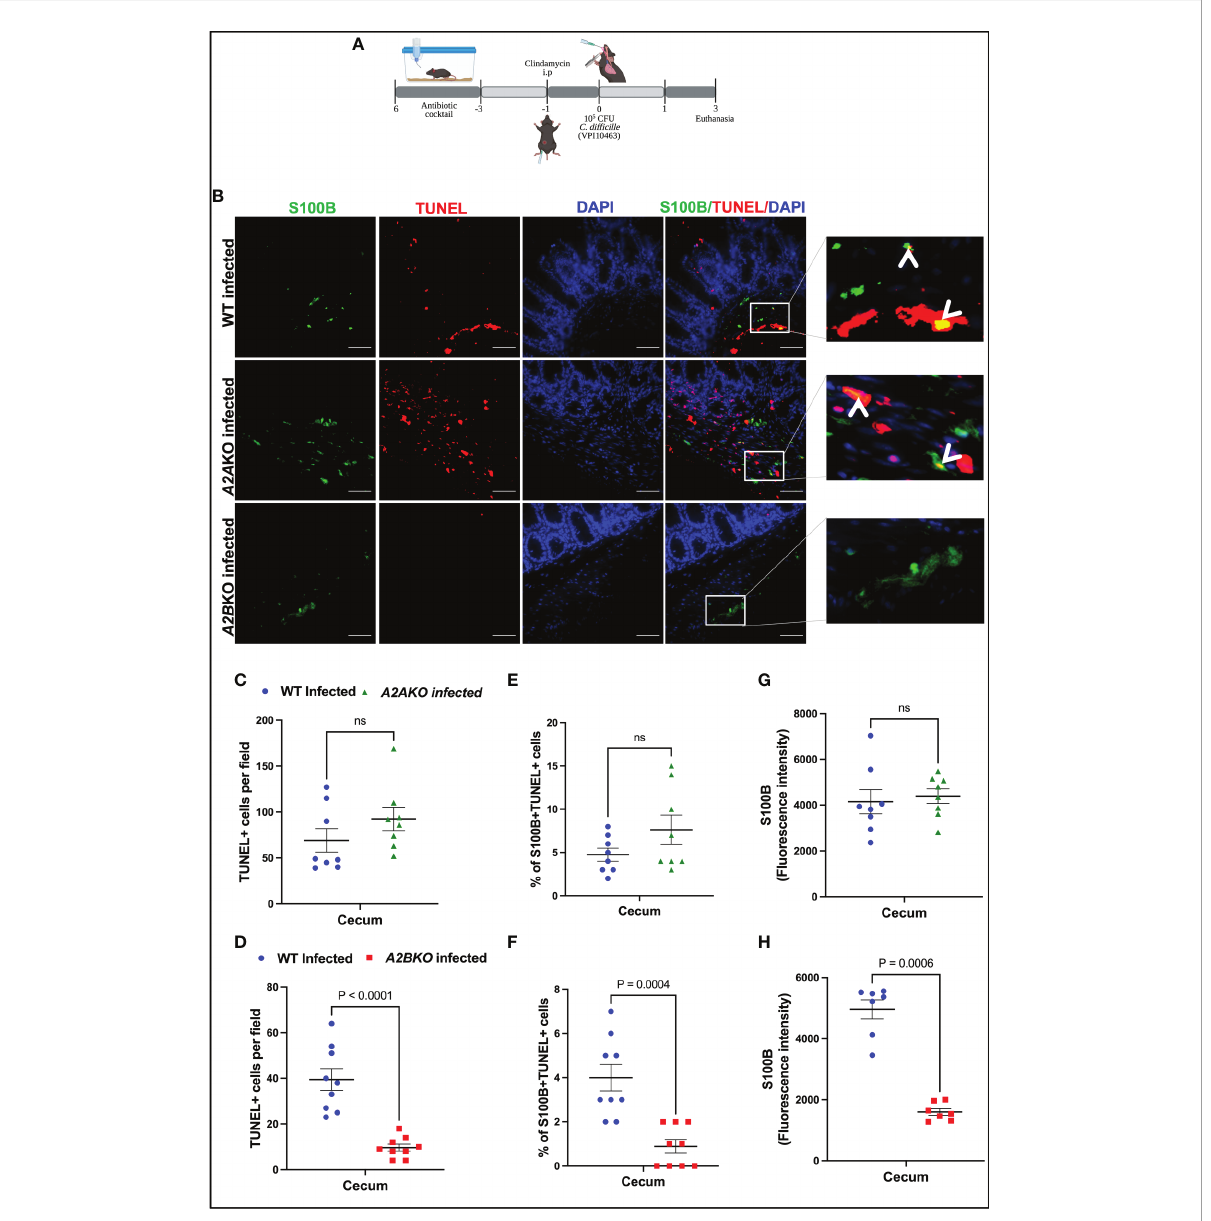
FIGURE 4 Deletion of A2B , but not A2A , prevents EGCs death induced by C . dif fi cile infection. (A) Scheme of C . dif fi cile infection (CDI) in mice. (B) Representative photomicrographs of S100B (green) immunostaining, TUNEL (red), and DAPI (blue) nuclear staining in cecum samples from WT, A2 AKO and A2 BKO mice on day 3 post C . dif fi cile infection. (C, D) Analysis of TUNEL+ cells (marker of dead cells) in cecum samples from WT, A2 AKO and A2 BKO mice on day 3 post C . dif fi cile infection (n=8-9). (E, F) Analysis of S100B+Tunel+ cells (dead EGCs) in cecum samples from WT, A2 AKO and A2 BKO mice on day 3 post C . dif fi cile infection (n=8-9). (G, H) Fluorescence intensity of S100B immunostaining measured by ImageJ software in cecum samples from WT, A2 AKO and A2 BKO mice on day 3 post C . dif fi cile infection (n=8-9). (C – H) Mann-Whitney ’ s test was used. ns, not signi fi